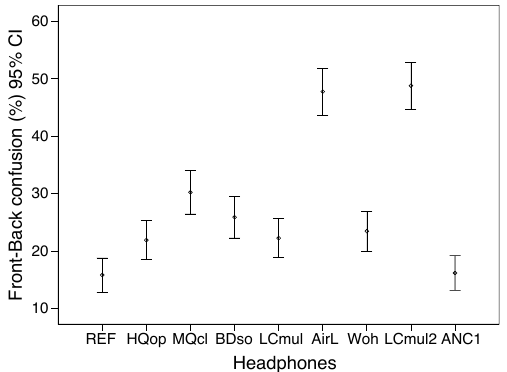
Figure 9. Percentage of front-back confusions for the reference, headphones and the